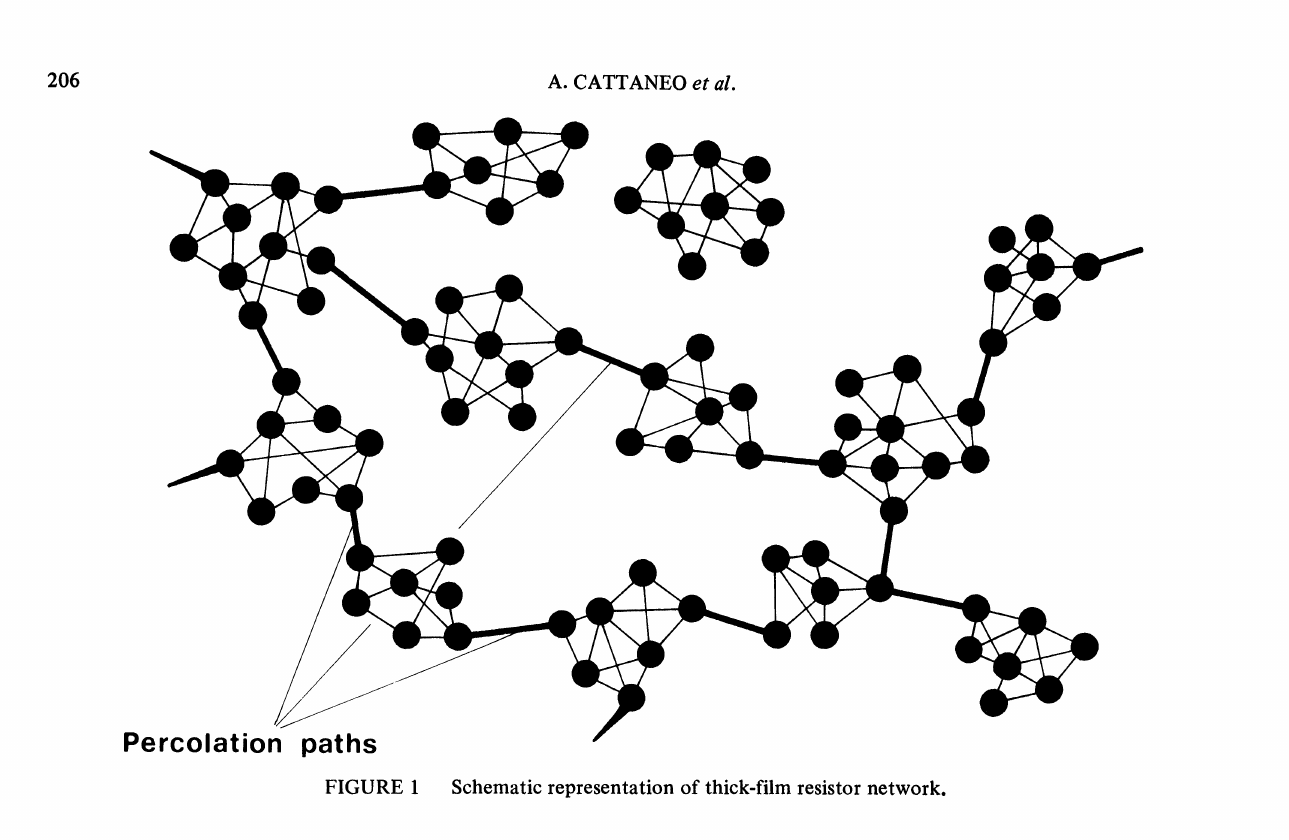
FIGURE Schematic representation of thick-film resistor